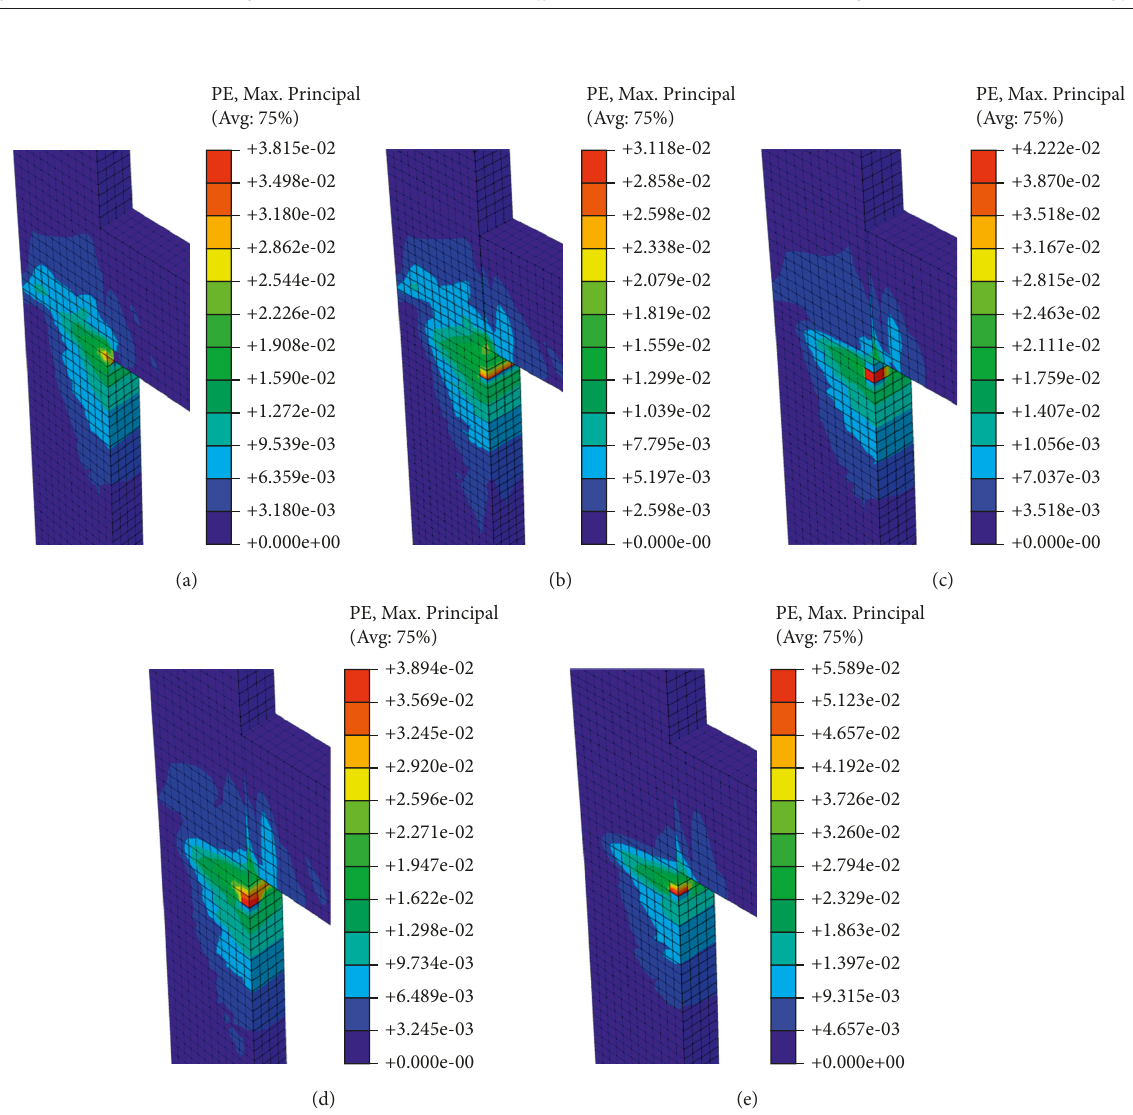
Figure 24: Crack pattern for specimens with various thicknesses of TRC: (a) G4M0, without TRC; (b) Referential, 0.003m; (c) G4M1, 0.006m; (d) G4M2, 0.01m; and (e) G4M3, 0.02m.